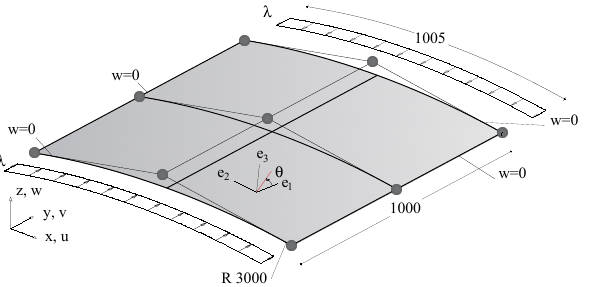
Figure 2. Geometry (lengths in mm), NURBS control grid, boundary conditions and